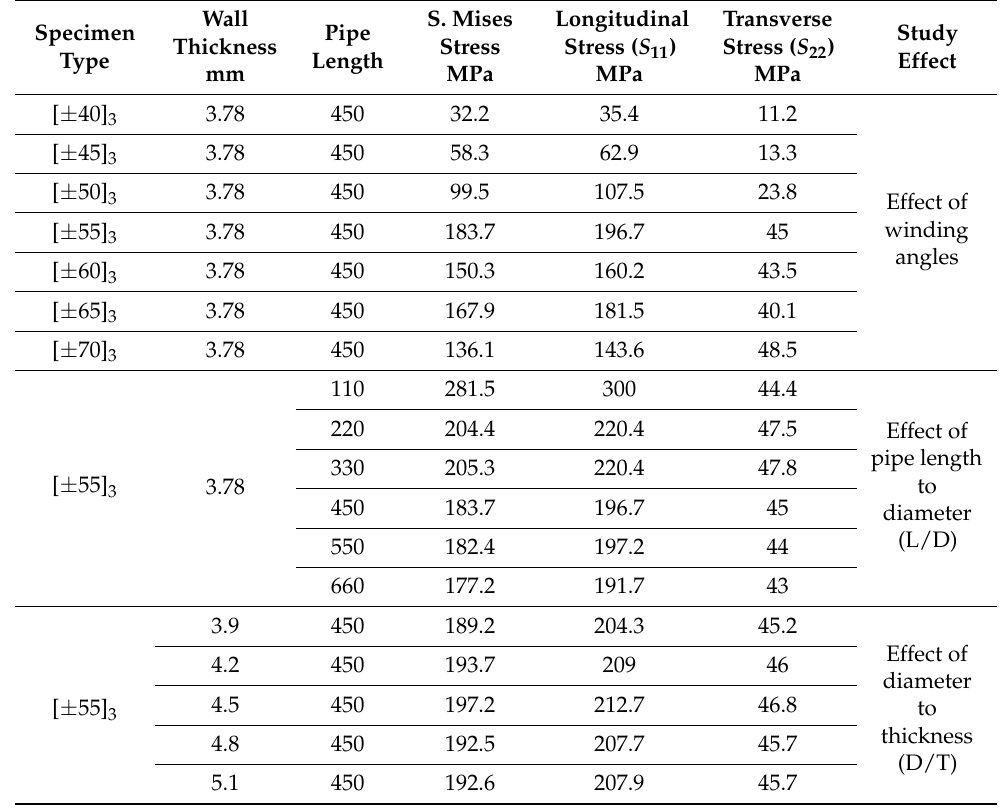
Table 6. Composite pipe specifications and simulation results of various